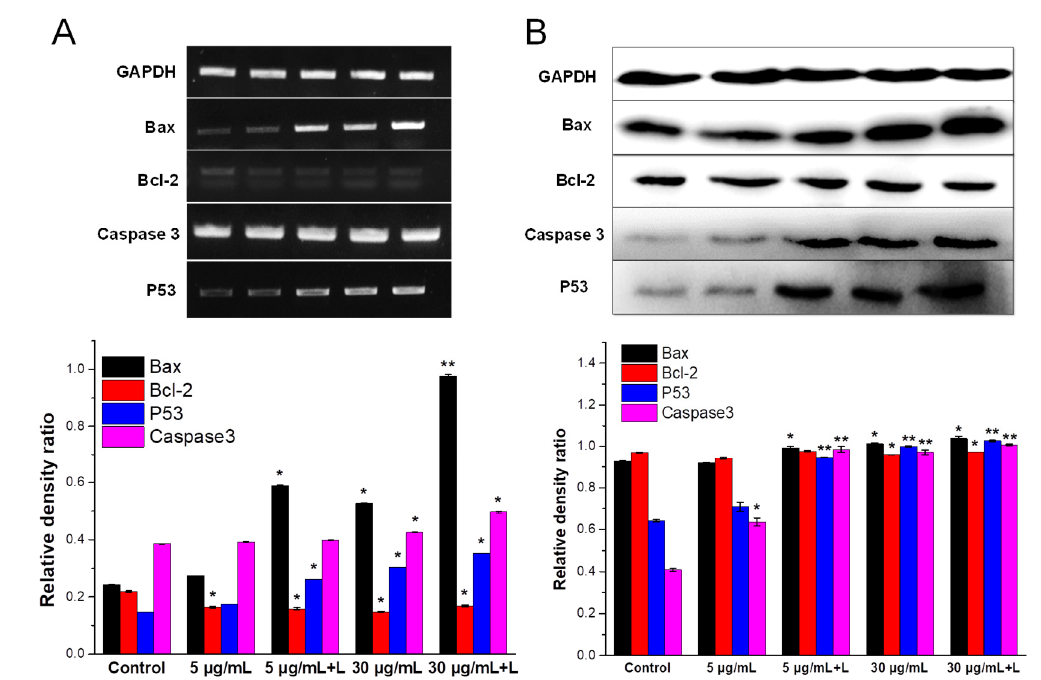
Figure 9. Effect of HA-capped AuNPs with/without NIR treatment on expression of apoptosis-related genes ( Bax , Bcl-2 , P53 and Caspase 3 ) in MDA-MB-231 cells, according to RT-PCR ( A ) and Western blot ( B ) assay. Relative mRNA or protein expression level for each gene were all normalized by internal control GAPDH and shown in respective bar graphs. * p < 0.05, ** p < 0.01 vs. control group.